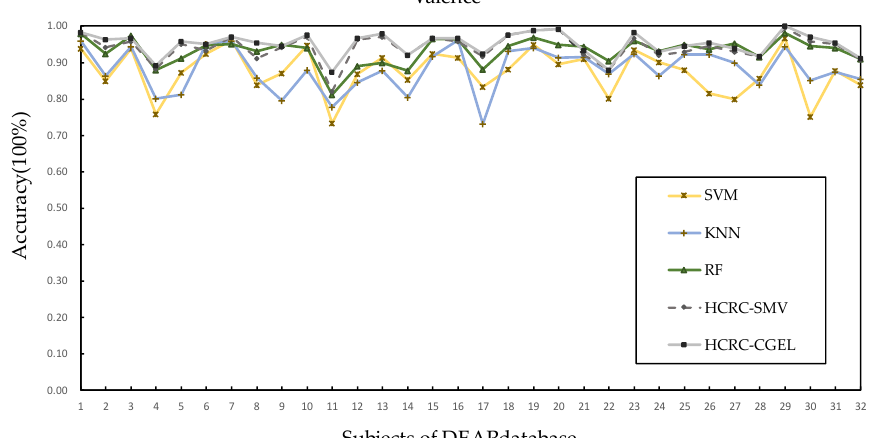
Figure 6. Results of each method for valence on DEAP database.